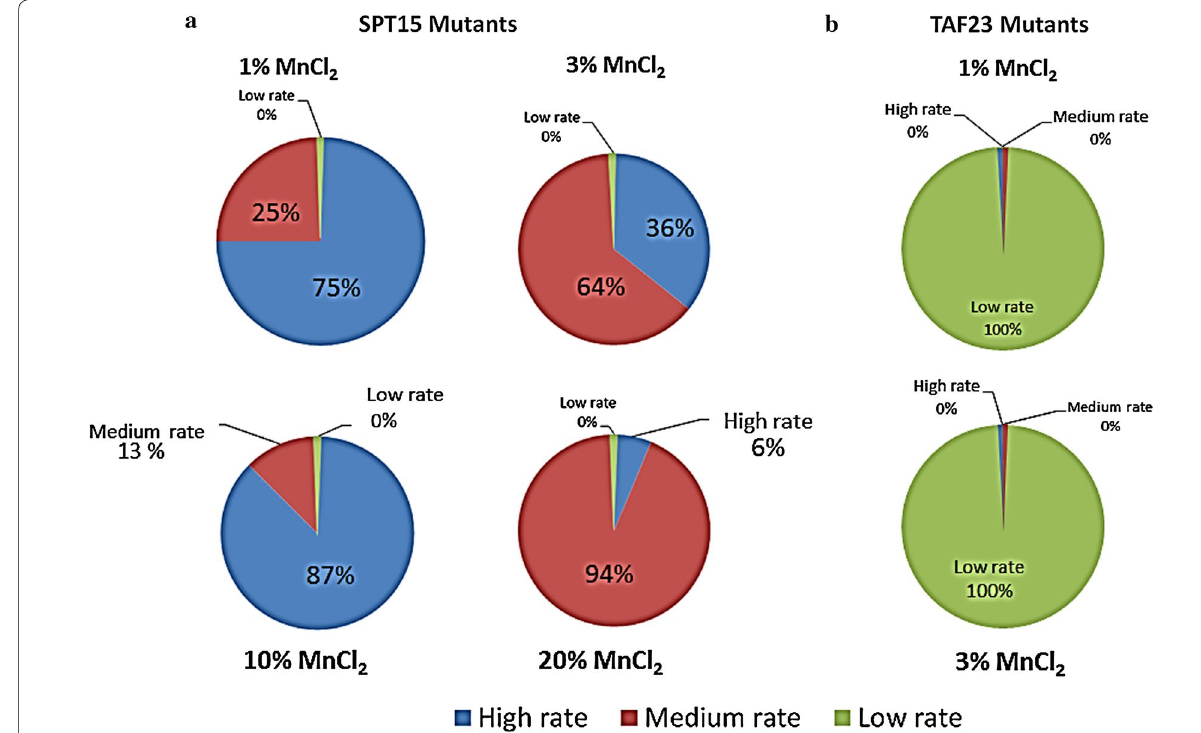
Fig. 2 a , b Summary of the mutation rate for SPT15 and TAF23 mutant